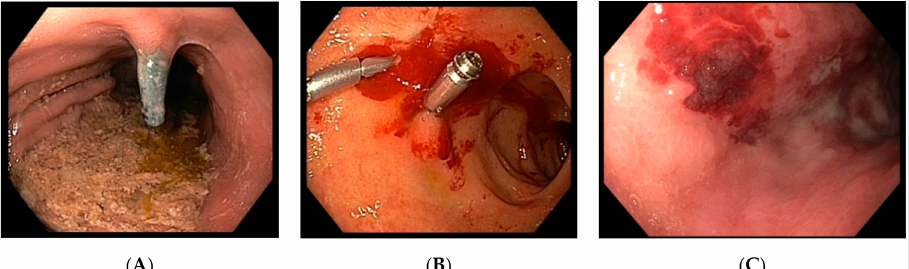
Figure 1. Bleeding sources in three patients included in the study. ( A ) Patient 7. Second look endoscopy after suspension of bleeding. Endoscopy showed a hemoclip in the body of the stomach at the small curvature. The bleeding originated from a visible vessel from an ulcer at an atypical location. ( B ) Patient 16. The endoscopy revealed active bleeding from an ulcer located in the duodenal bulb. The bleeding was rated as Forrest 1b. Hemostasis was finally achieved with hemoclips. ( C ) Patient 9. Endoscopy revealed several ulcers in the stomach with one showing bleeding signs (coagulum) rated as Forrest 2b. As no active bleeding was obvious, the endoscopist did not intervene, and conservative therapy with proton pump inhibitors was